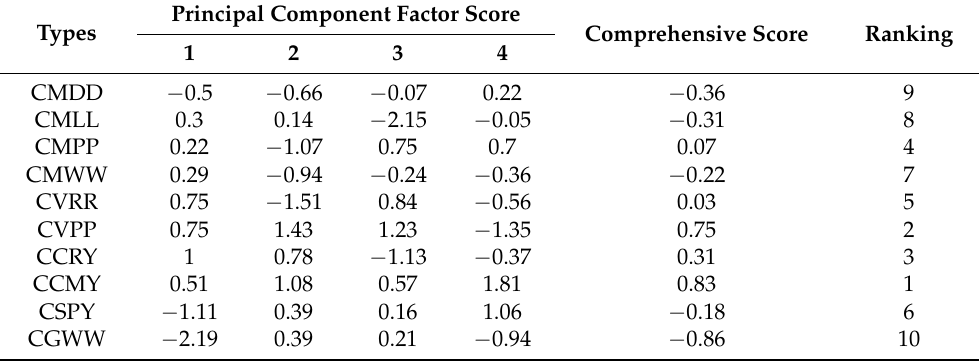
Table 5. The first four principal component factor scores, as well as the overall scores and